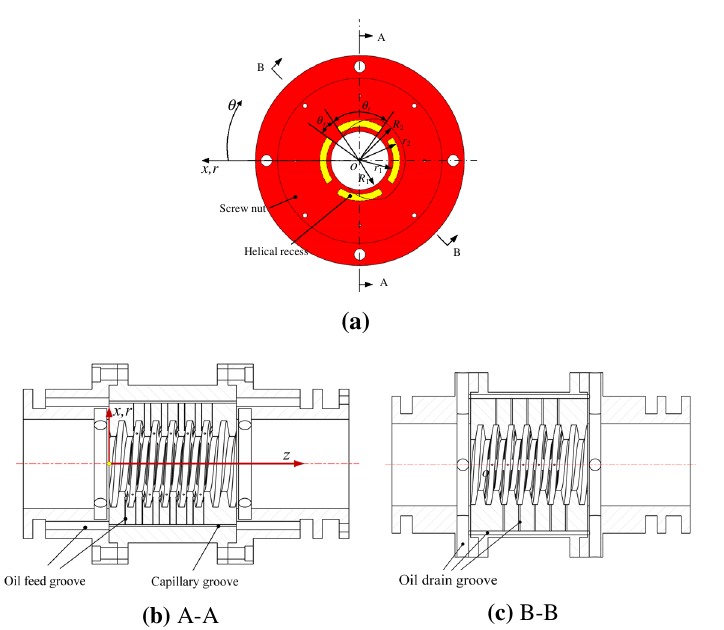
Figure 3. Internal structure and oil circuit of nut ( a ) Layout of the helical recesses, ( b ) A-A cross-section of the hydrostatic nut, ( c ) B-B cross-section of the hydrostatic